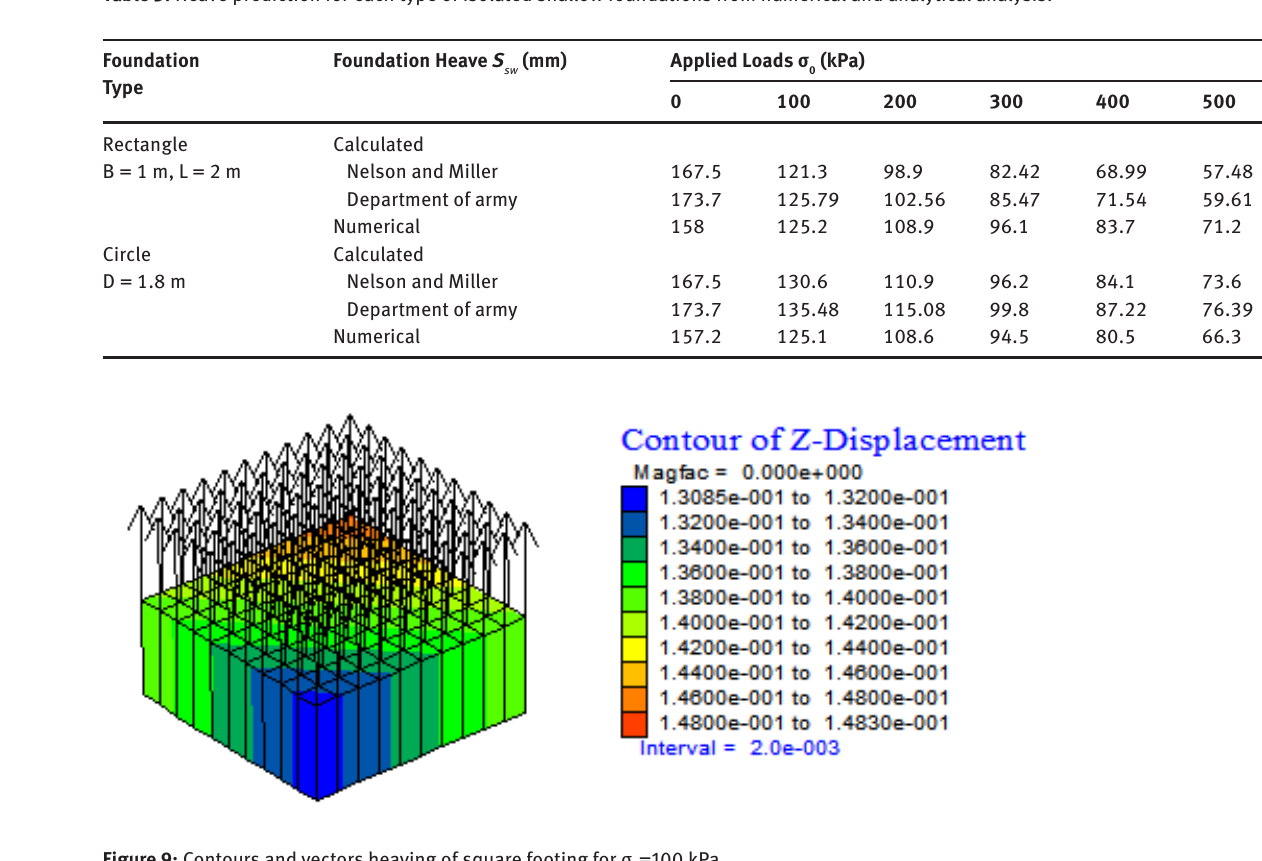
Figure 9: Contours and vectors heaving of square footing for σ